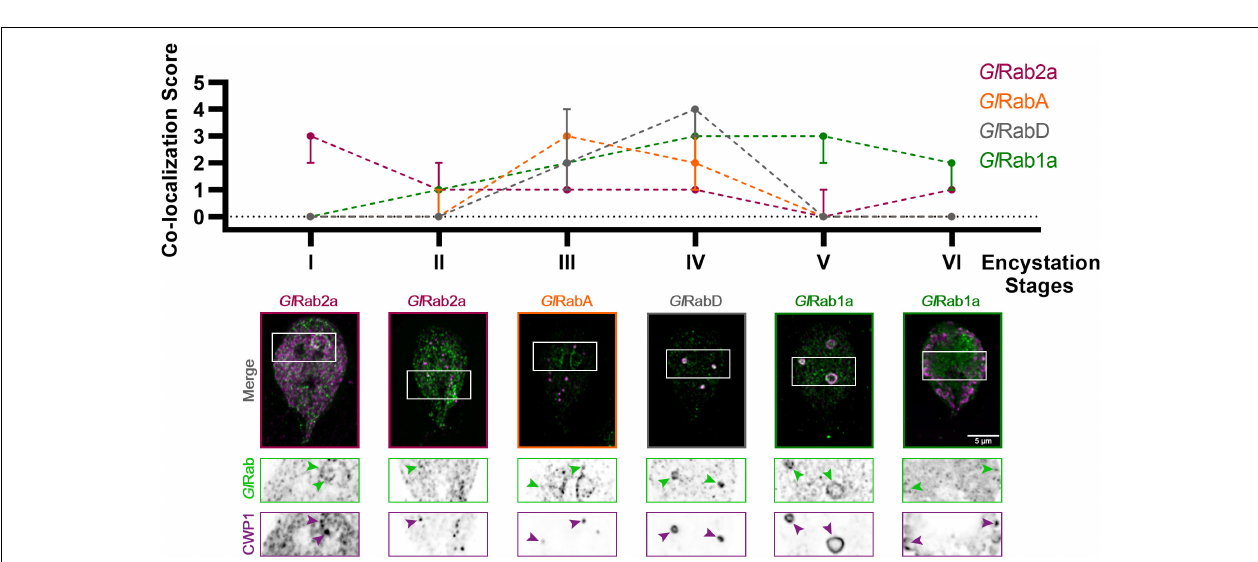
FIGURE 2 | Giardia Rabs associate with ESVs during encystation in a stage-specific manner. Summary of findings from colocalization analysis of Giardia Rabs and CWP1 through all the encystation stages described above. Cells expressing endogenously tagged mNG- Gl Rabs were subjected to the two-step encystation process. They were then harvested at 8 and 24 h p.i.e. to be fixed and stained for CWP1. 15–20 cells per encystation stage were then imaged to visualize mNG-tagged Gl Rabs (green) and CWP1 (magenta) and scored for the level of colocalization between the tagged Gl Rabs and CWP1 stained structures. Plot shows median scores with 95% confidence interval. Arrowheads indicate mNG- Gl Rabs colocalizing with CWP1-stained